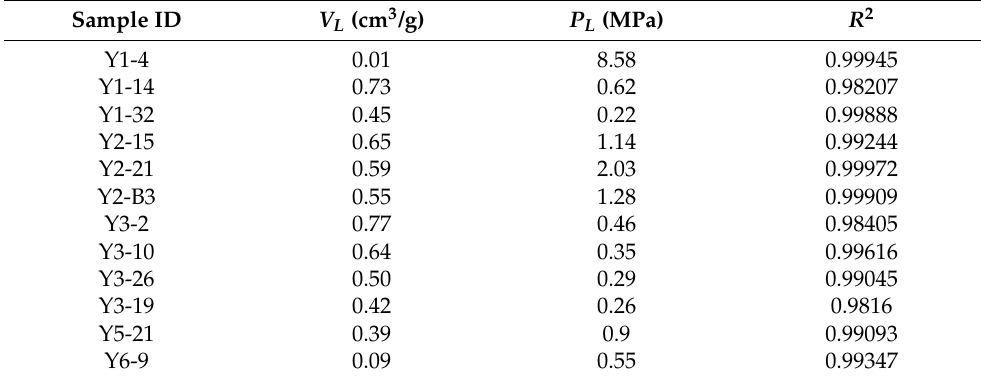
Table 3. The Langmuir fitting results of isothermal adsorption